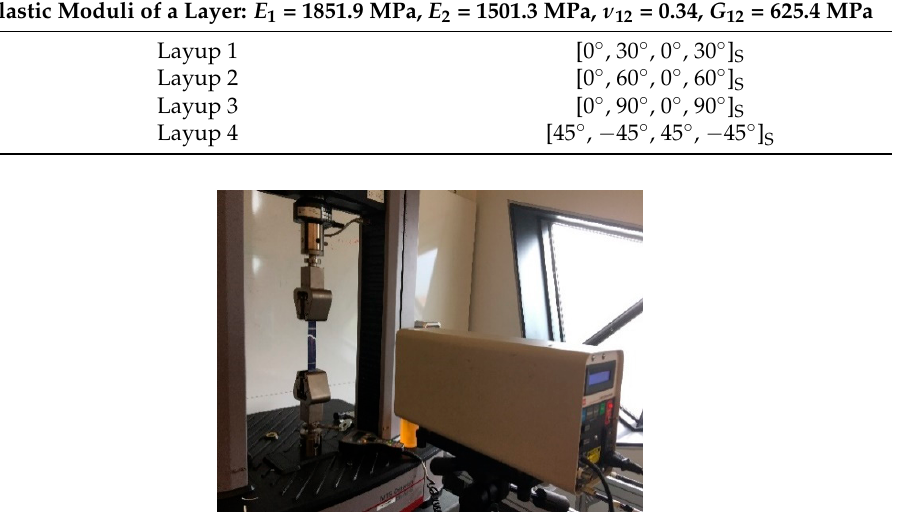
Table 6. Elastic constants of a layer and symmetric lamina layup of the tensile specimen.